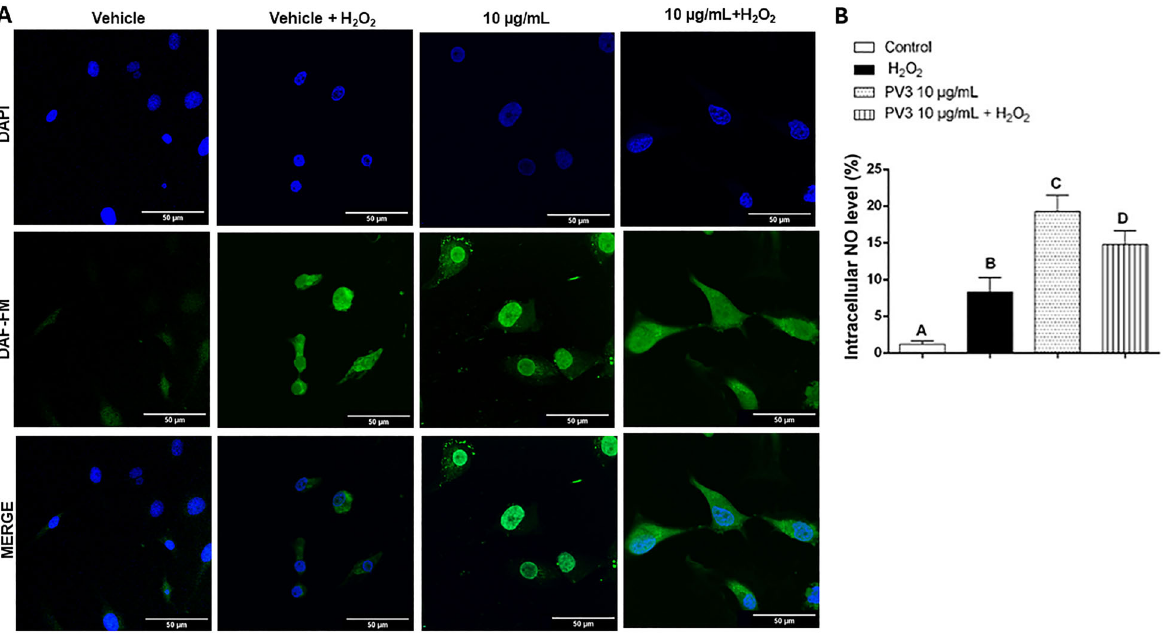
Figure 2. A , Effect of Phaseolus vulgaris peptide (PV3) extract on nitric oxide (NO) production with and without oxidative stress caused by 3% H 2 O 2 for 1 h by DAF-FM probe and confocal microscopy (scale bar 50 m m). B , Quanti fi cation of pixels generated from the speci fi c excitation of NO molecules. The data are reported as means ± SE. P o 0.05, different upper-case letters indicate that all groups differed from each other (ANOVA and Fisher